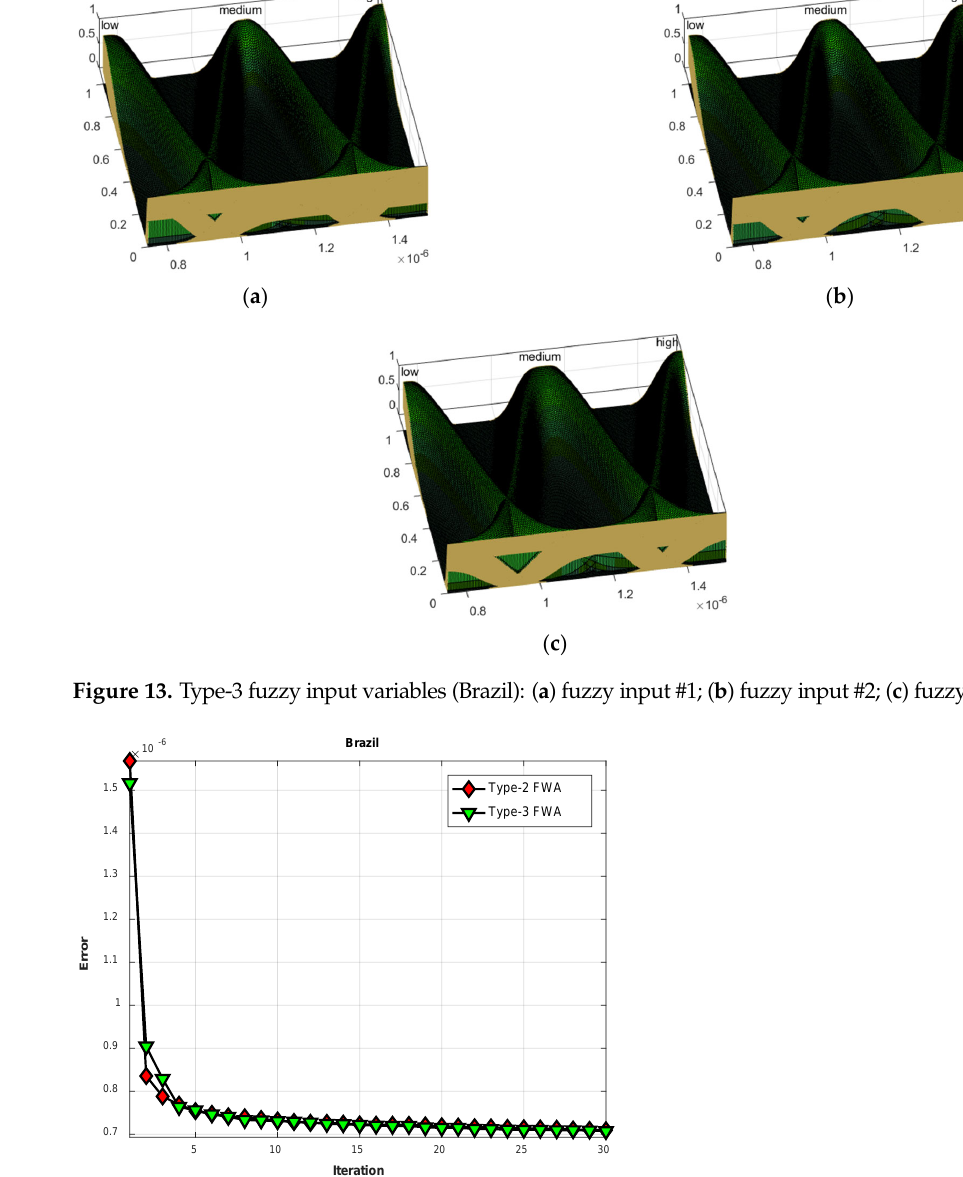
Figure 14. Average convergence for Brazil. Table 4. First data period (testing prediction,